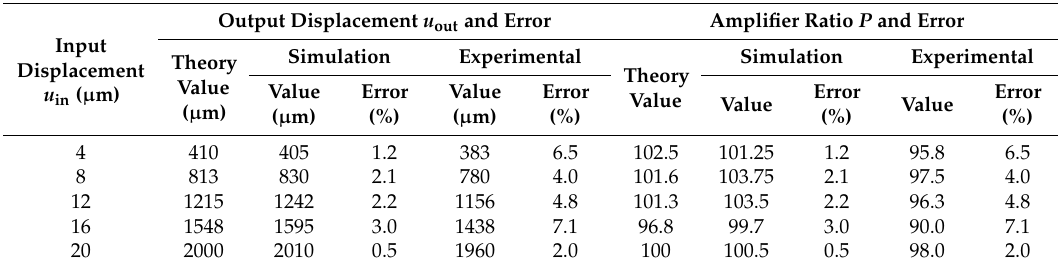
Table 5. Error analysis for the output displacement and amplifier ratio by comparing the theory, simulation, and experiment